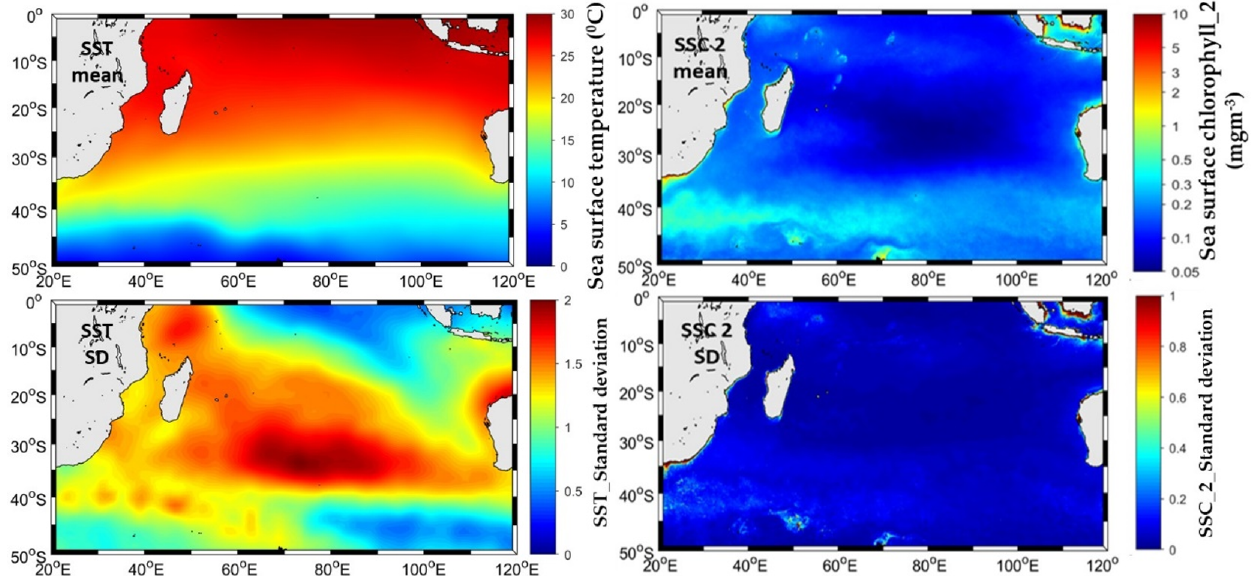
Figure 3. Mean and standard deviations (SD) of SST and SSC_2 from 2000 to